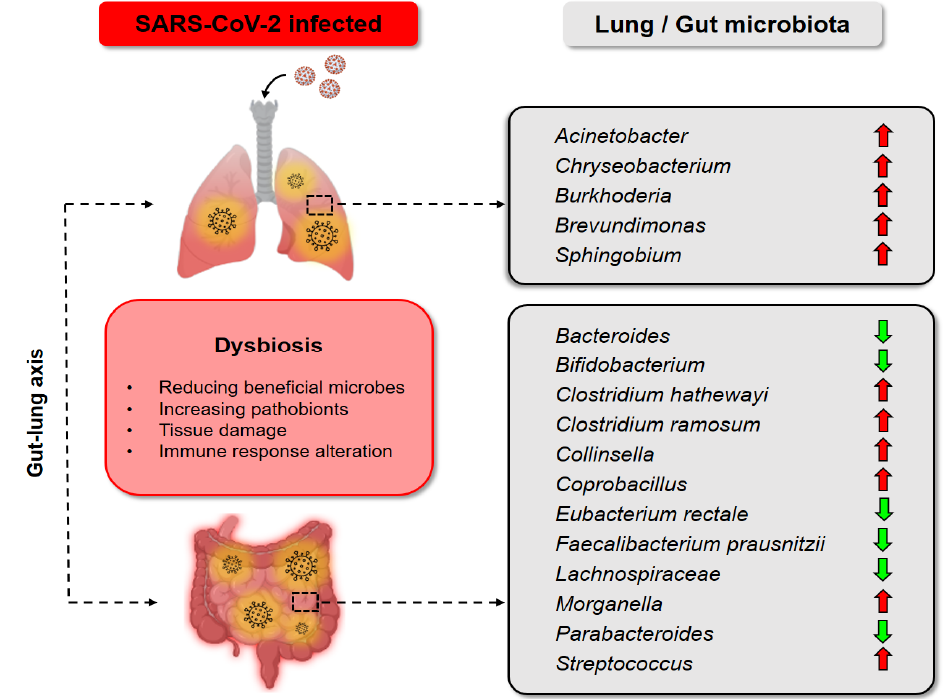
Figure 2. Dysbiosis of gut and lung in COVID-19 patients. In the lung of SARS-CoV-2 infected patients, Acinetobacter , Chryseobacterium , Burkhoderia , Brevudimonas , and Sphingobium were prevalent [74]. The gut microbiota of COVID-19 patients was also altered, with the decrease of Bacteroides [69], Bifidobacterium [68], Eubacterium rectale [68], Faecalibacterium prausnitzii [73], Lachnospiraceae [69], Parabacteroides [69], and the increase of Clostridium hathewayi [71], Clostridium ramosum [71], Collinsella [69], Coprobacillus [71], Morganella [69], Streptococcus [69].